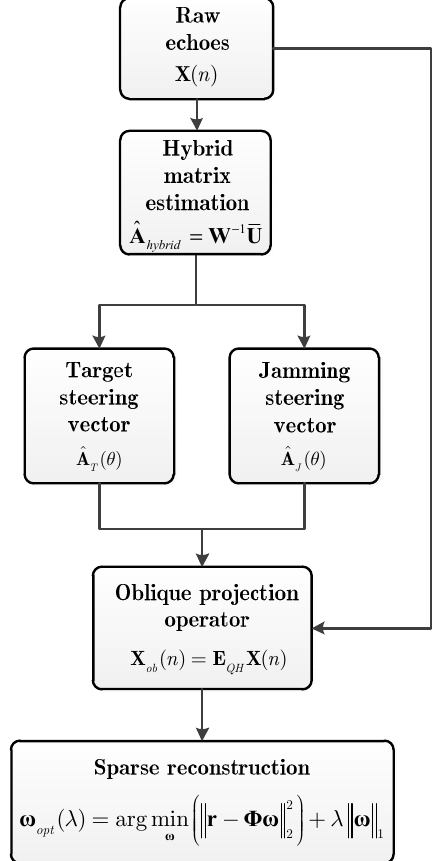
Figure 3. Flowchart of the proposed method.